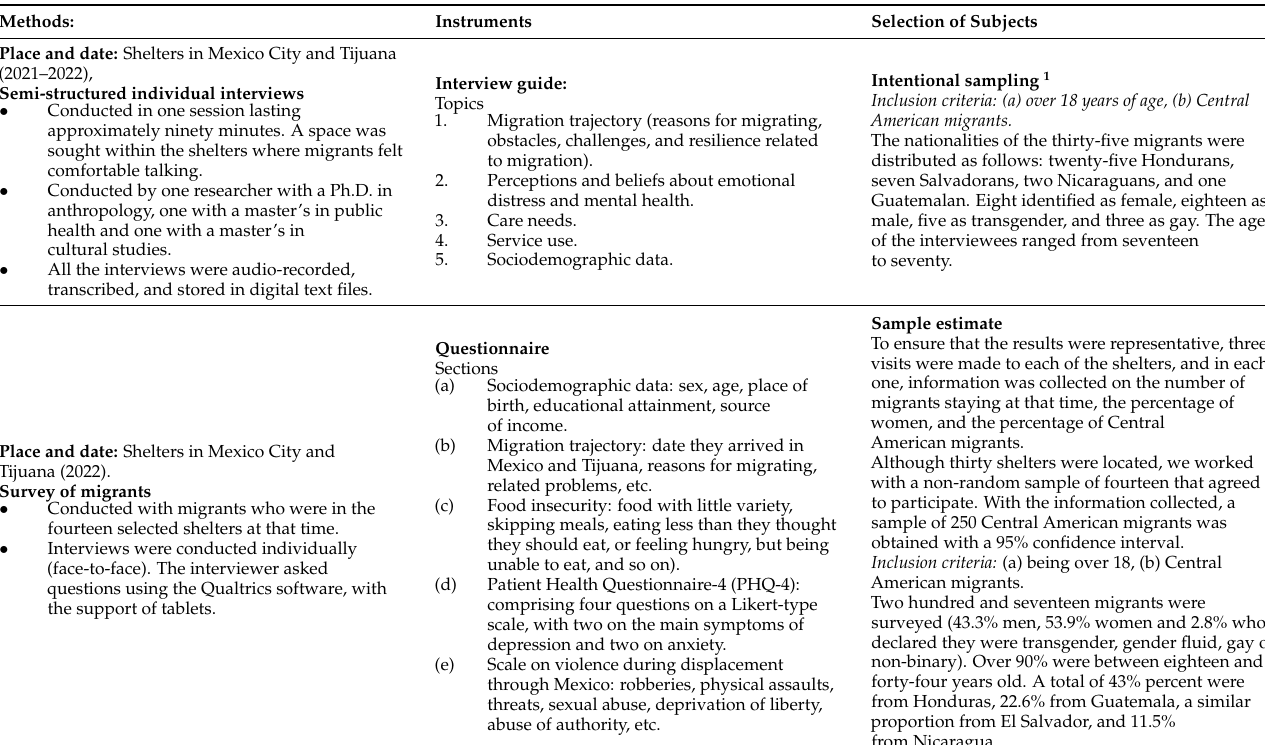
Table 1. Data Collection